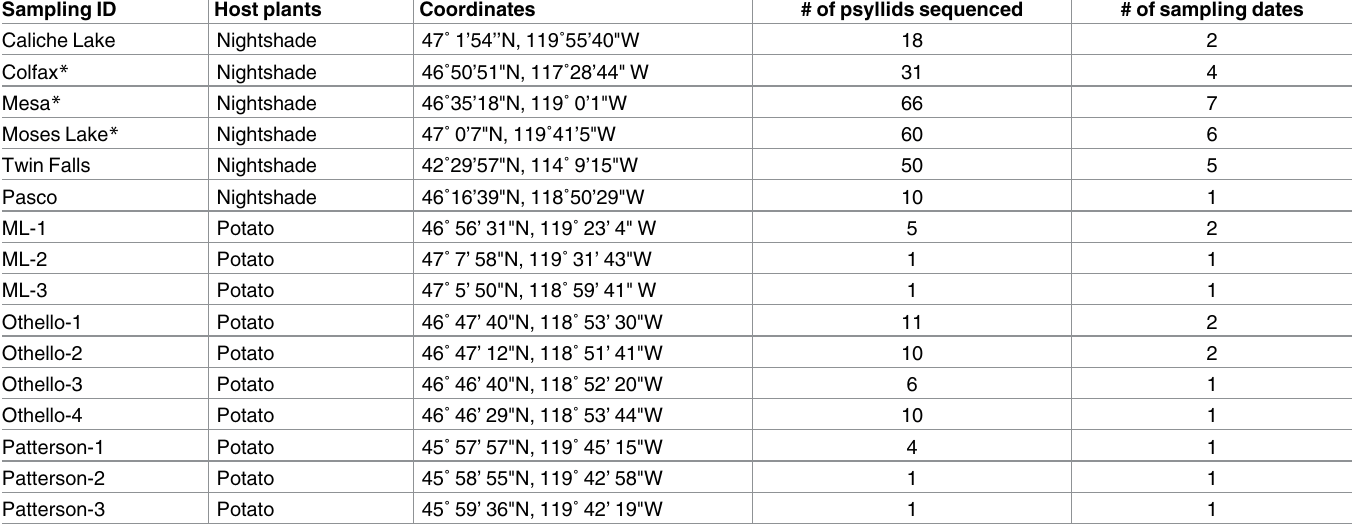
Table 1. Sampling locations and sampling dates of potato psyllids Bactericera cockerelli in the states of Washington and Idaho, United States of